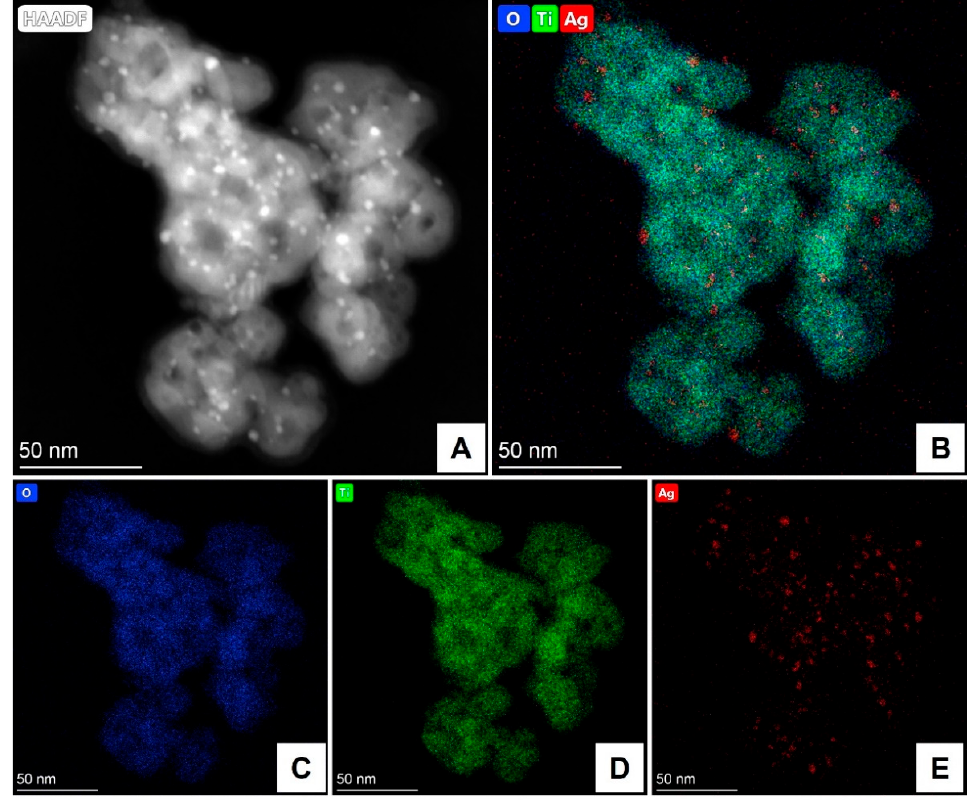
Figure 5. The energy-dispersive X-ray spectroscopy mapping image of laser-prepared Ag/TiO 2 nanocomposites. ( A ) High-angle annular dark field (HAADF). ( B ) Mixed. ( C ) O element. ( D ) Ti element. ( E ) Ag element. Reprinted with permission from Ref. [44].